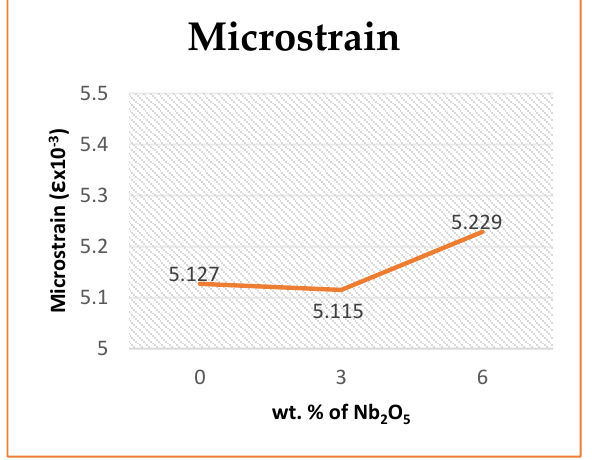
Figure 7. The grain shows the microstrain.